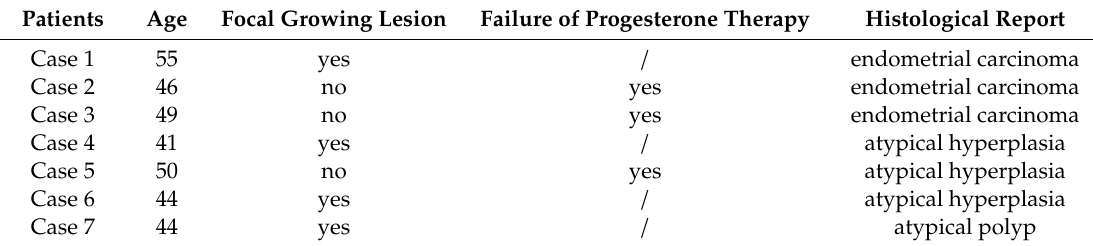
Table 3. Clinical characteristics of positive histological reports of malignant or premalignant lesions in the study